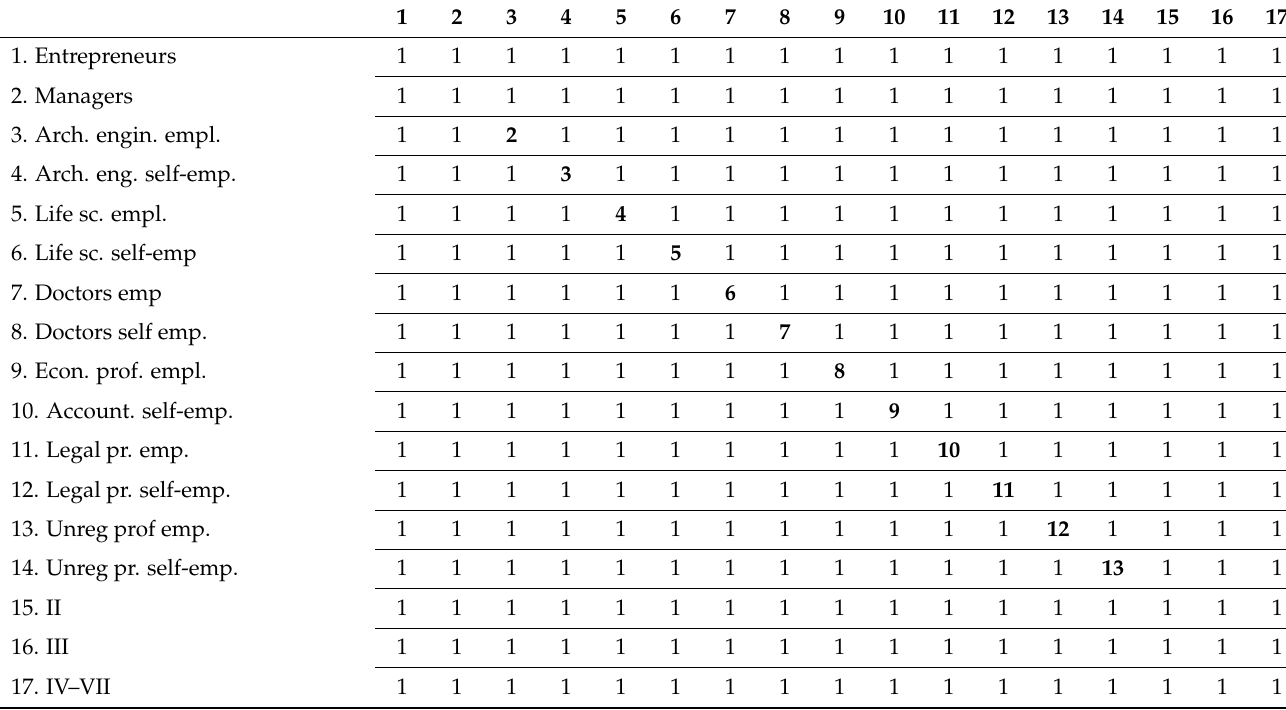
Figure A1. Beta parameters for micro-class social immobility specifying between self-employed and employed within each micro-class. Beta parameters with confidence intervals are extrapolated from Model 7a.